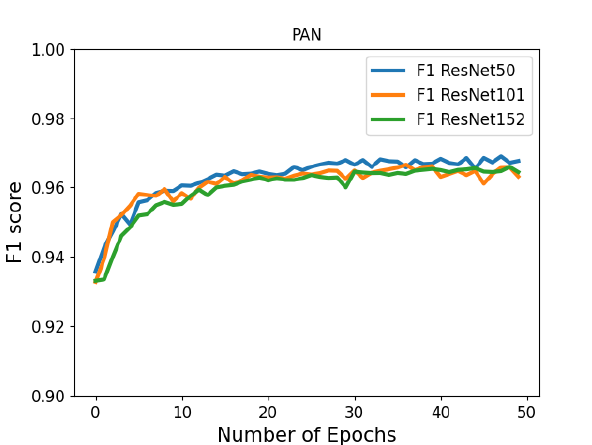
Figure 7 . F1 score for training with ResNet50(blue), ResNet101(orange) and ResNet152(green) for PAN network.